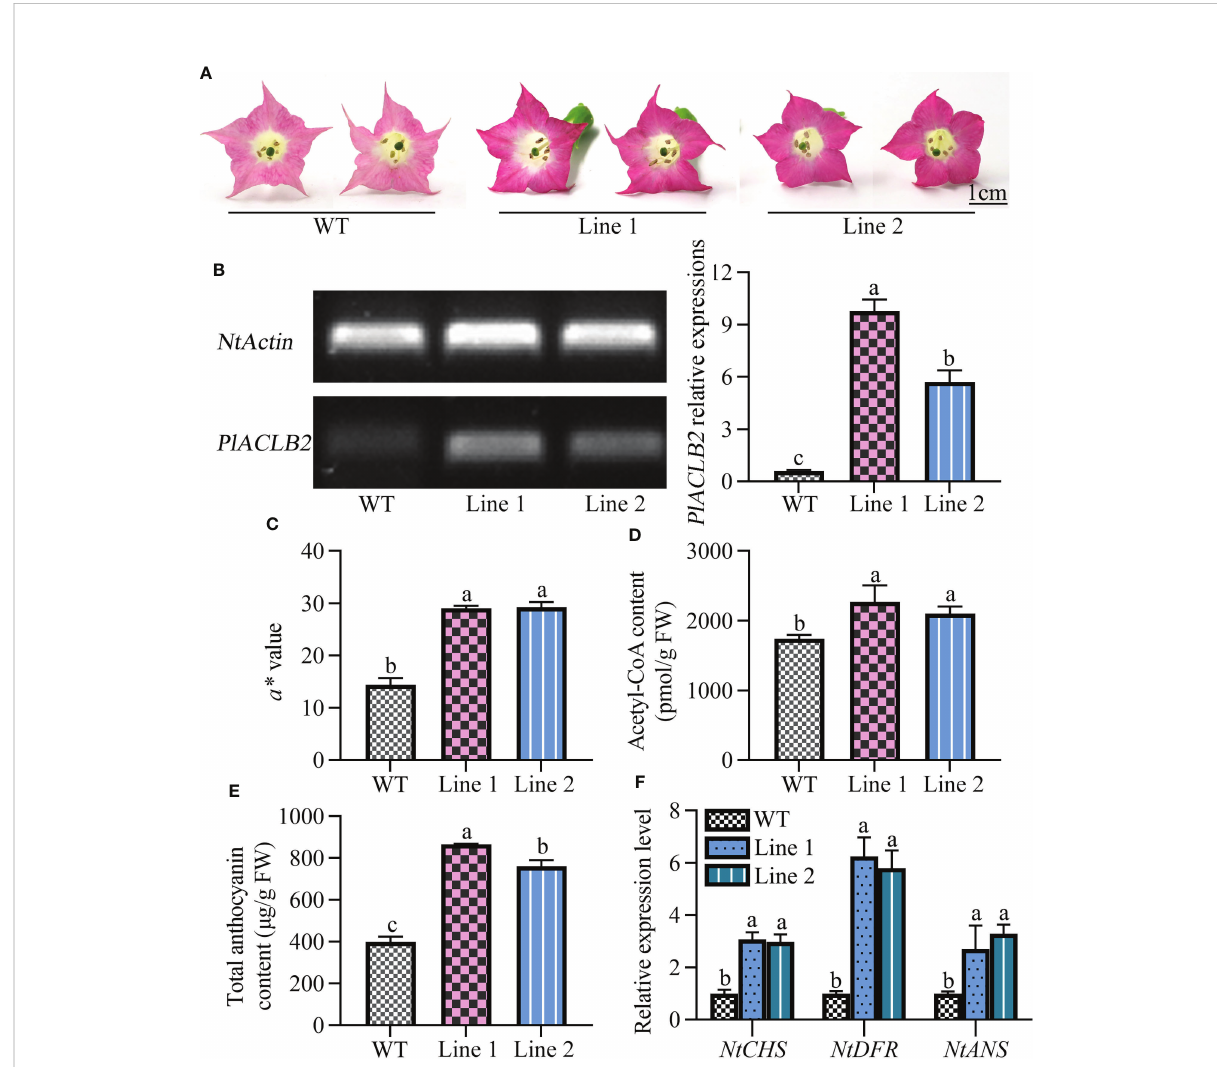
FIGURE 7 Stable transformation of PlACLB2 in tobaccos. (A) Flower phenotype changes of the WT and PlACLB2 transgenic tobaccos. (B) Expression analysis of PlACLB2 in the WT and PlACLB2 transgenic tobaccos validated by PCR and qRT-PCR. (C) Measurement of red representing a* value and total anthocyanin content in the WT and PlACLB2 transgenic tobaccos. (D) Measurement of acetyl-CoA content in the WT and PlACLB2 transgenic tobaccos. (E) Measurement of total anthocyanin content in the WT and PlACLB2 transgenic tobaccos. (F) Expression levels of anthocyanin biosynthesis related genes in the WT and PlACLB2 transgenic tobaccos. WT, wild type. The values represent the means ± SDs, and different letters indicate signi fi cant differences ( P <